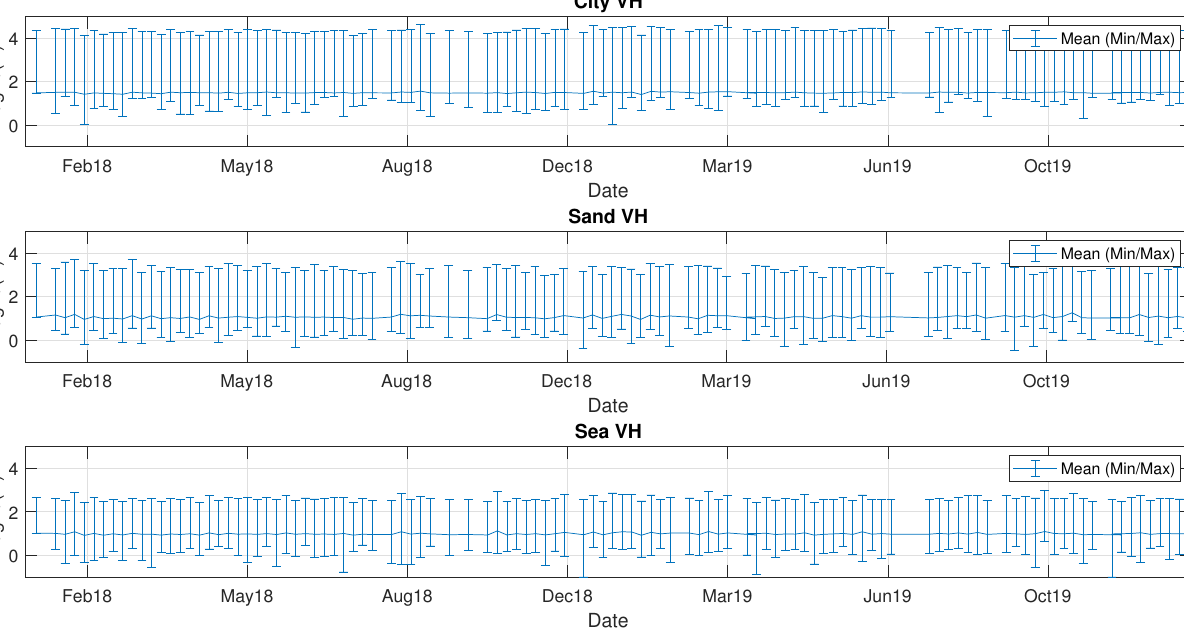
Figure 6. Comparison between ranges and mean amplitude values over 2 years for the city (first raw), sand (second raw), and sea (third raw) masks (VH polarization). Similar conditions occur compared to VV polarization, but the variability of the three masks is lower; amplitude values in VH polarization always range lower than VV